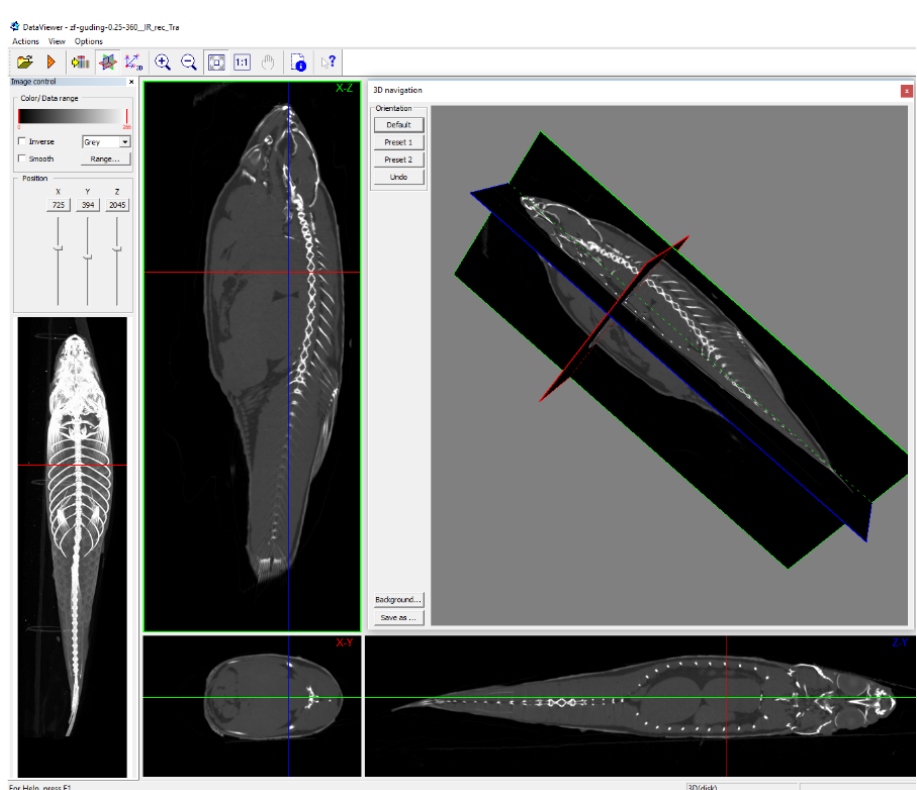
Figure 8. Simulated 2D slice observation in the 2D viewing software DataViewer.